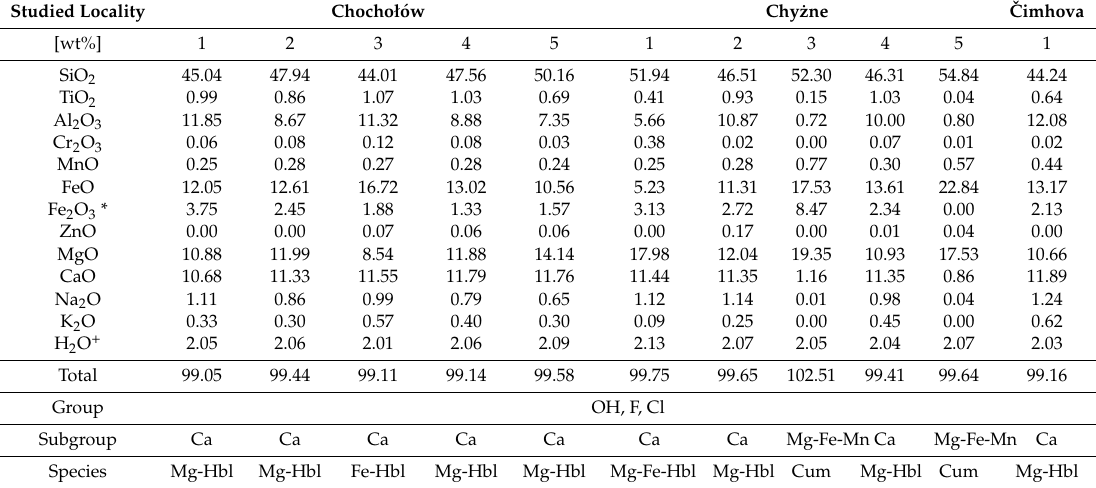
Figure 10. Composition and classification of the amphibole grains studied [69]. Data on minerals from rocks of the Tatra Mountains come from Gaw˛eda et al. [76] and Jan á k et al. [77,78]). Table 5. Representative amphibole composition from the Chochoł ó w and Chy˙zne sites and amphibole composition from the ˇCimhova site.